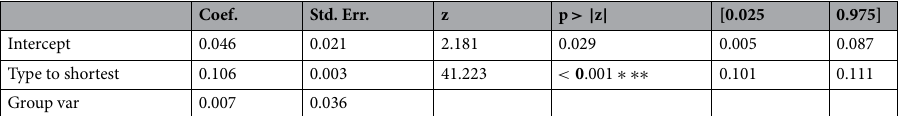
Table 5. Results of the ‘ Difference in Average Cosine Similarity ’ mixed linear model regression, diffCos ∼ AgentType + ( 1 | Agent ) , we denote p-values satisfying the Bonferroni corrected alpha with ***.